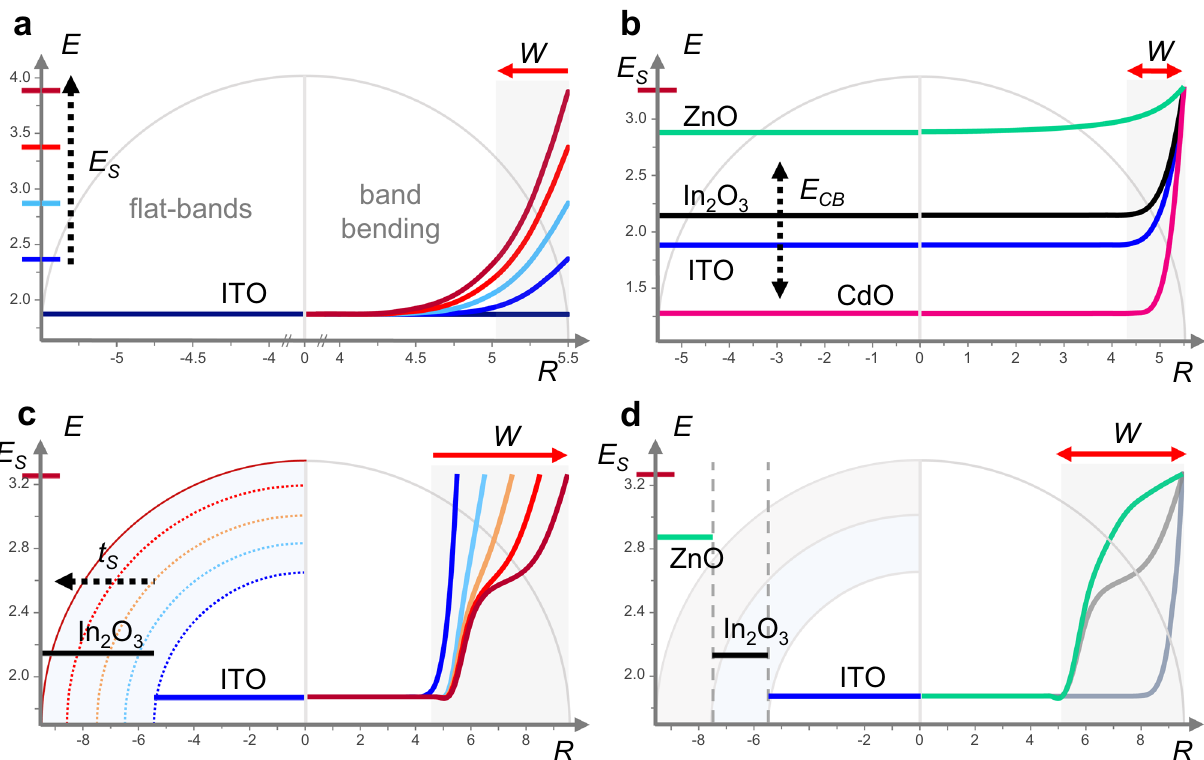
Fig. 1 Depletion layer engineering of metal oxide NCs via tuning of structural and electrical properties. The morphology of the nanocrystal (NC) is illustrated by a semi-circle with its extension R in the abscissa (in nm) and the energy in the ordinate (in eV). In each panel, the left side of the sphere represents the fl at-band potentials in the non-equilibrium condition, while the right side reports the band bending due to the Fermi level pinning (with the shaded region indicating the depletion width, W ). Band pro fi les were calculated by numerically solving the Poisson ’ s equation. a Tuning of surface state potentials ( E S ). Increasing the E S results in the expansion of the depletion width, W (progressively from blue to red). b Impact of different materials on W at fi xed E S . c Expansion of W and double bending of the depletion layer in a core – shell structure of ITO-In 2 O 3 with a core radius ( R core ) of 5.5nm and varying shell thickness ( t s ¼ 0 ; 1 ; 2 ; 3 ; 4 nm, i.e., blue, light blue, orange, red and dark red, respectively). d Multiple shell system by combining an ITO core ( R core = 5.5nm) with a In 2 O 3 and ZnO shell, with total radius R = 9.5nm. The band shows a complex pro fi le with a triple bending (green curve). The gray curves illustrate the previously reported case of a uniform ITO NC (dark gray) and an ITO-In 2 O 3 core – shell NC (light gray) with total radius R = 9.5nm for